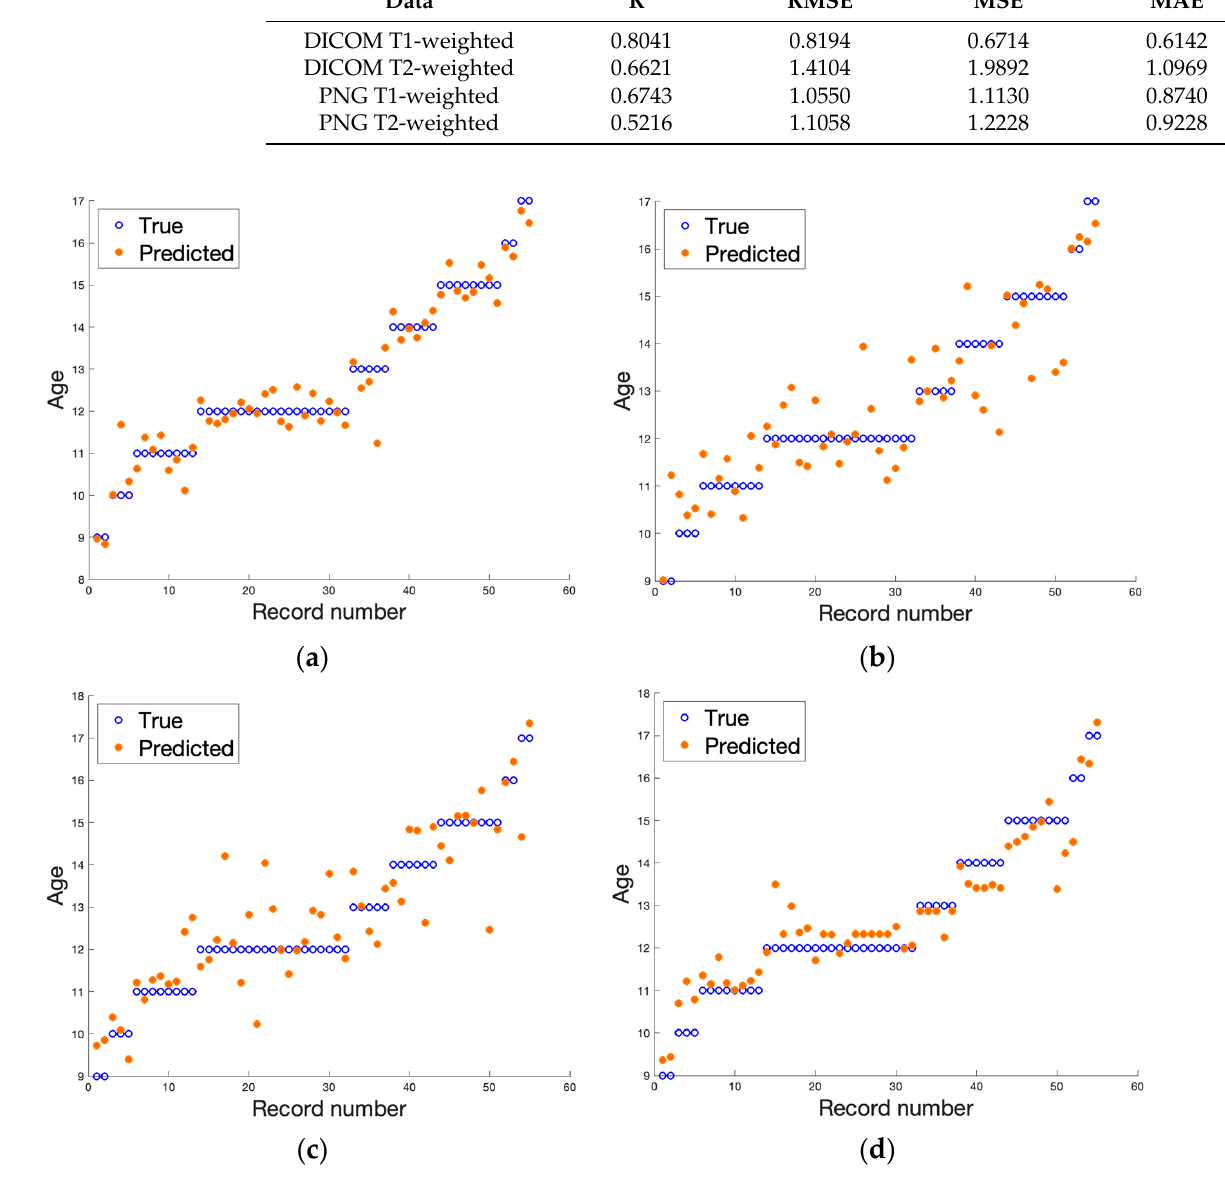
Figure 3. The result of regression algorithms for all cases examined for data describing bone images (metric). The real age is presented by blue circles and estimated age with a regression algorithm is depicted by orange dots. The samples are ordered on the y axis with increasing age. ( a ) DICOM